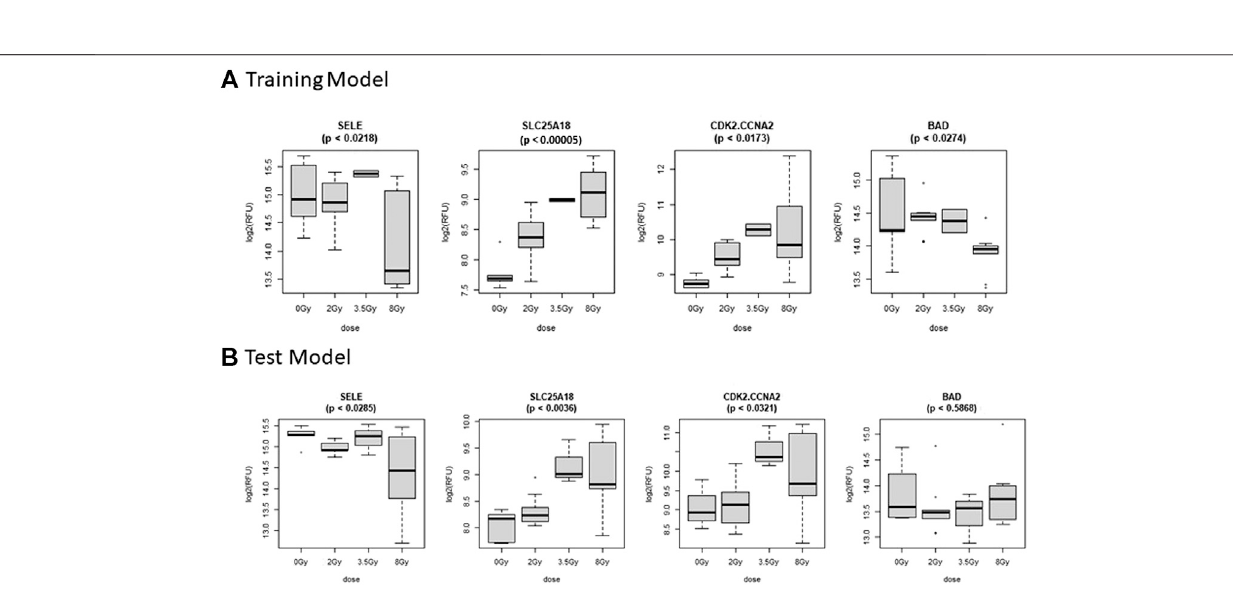
Frontiers in Pharmacology |